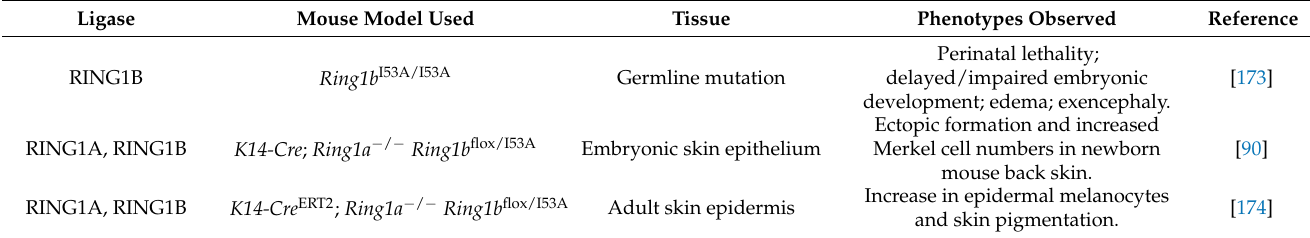
Table 1. Genetic mouse models for catalytic-inactive PRC1